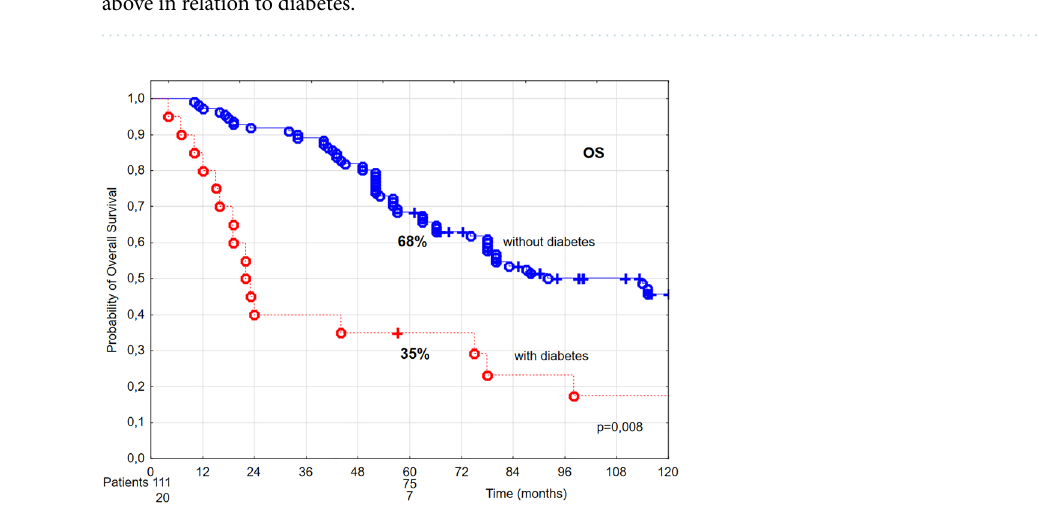
Figure 8. The probability of 5-year overall survival (OS) in T1 glottic cancer patients aged 70 and above in relation to